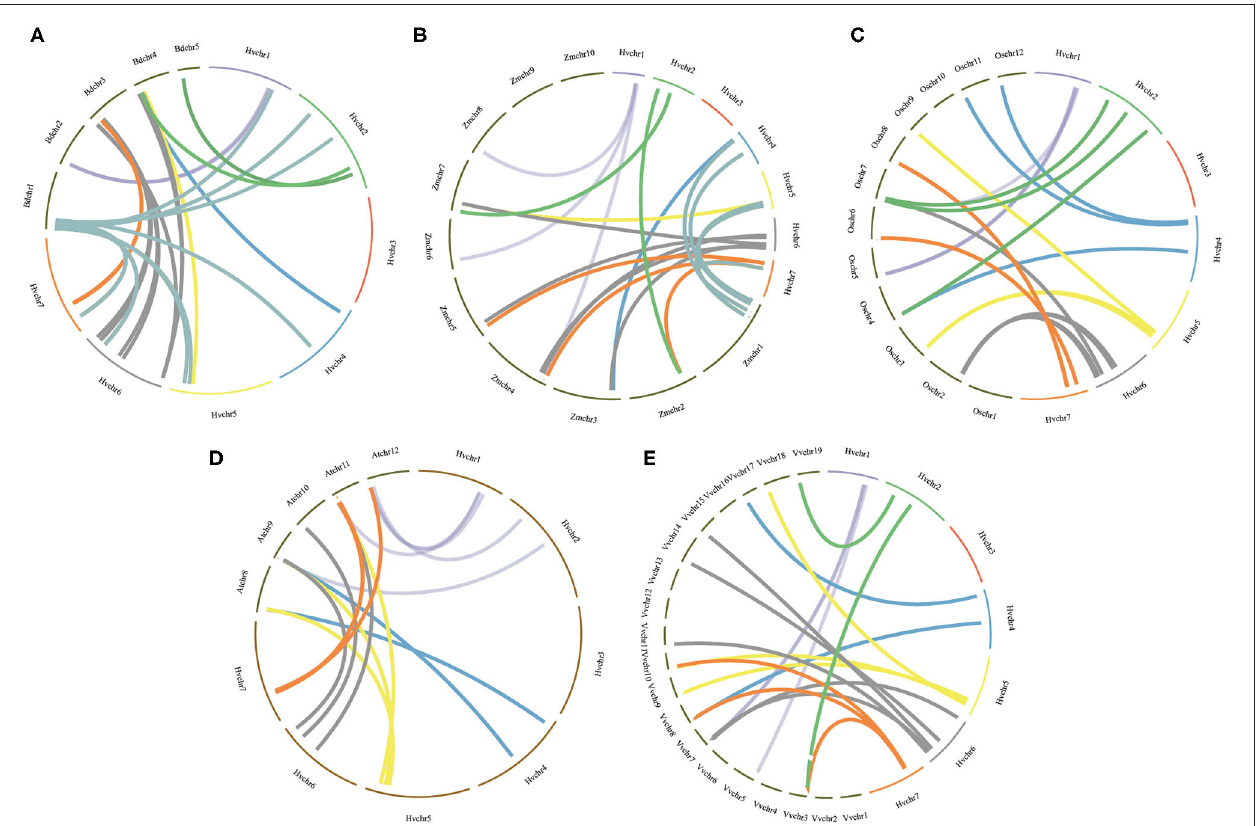
FIGURE 4 | Orthologous analysis of HvmTERF s between barley and other five representative plant species. (A) Brachypodium distachyon , (B) Zea mays , (C) Oryza sativa , (D) Arabidopsis thaliana , (E) Vitis vinifera .